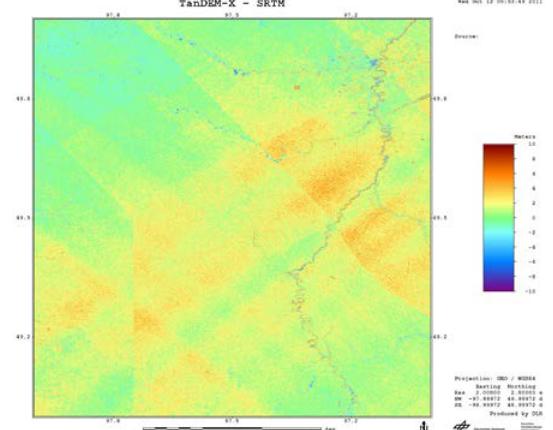
Figure 4: Difference between TanDEM-X and SRTM-C tile N49W98, range of values [-10; 10]